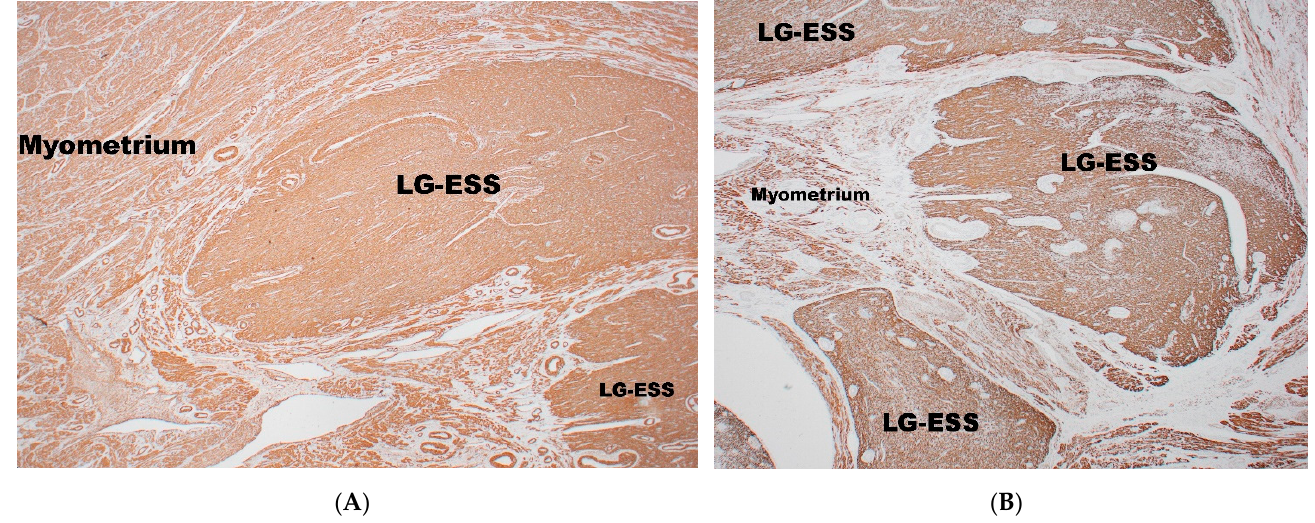
Figure 4. Smooth muscle actin ( SMA)-positivity ( A ) and desmin-positivity ( B ) in LG-ESS.